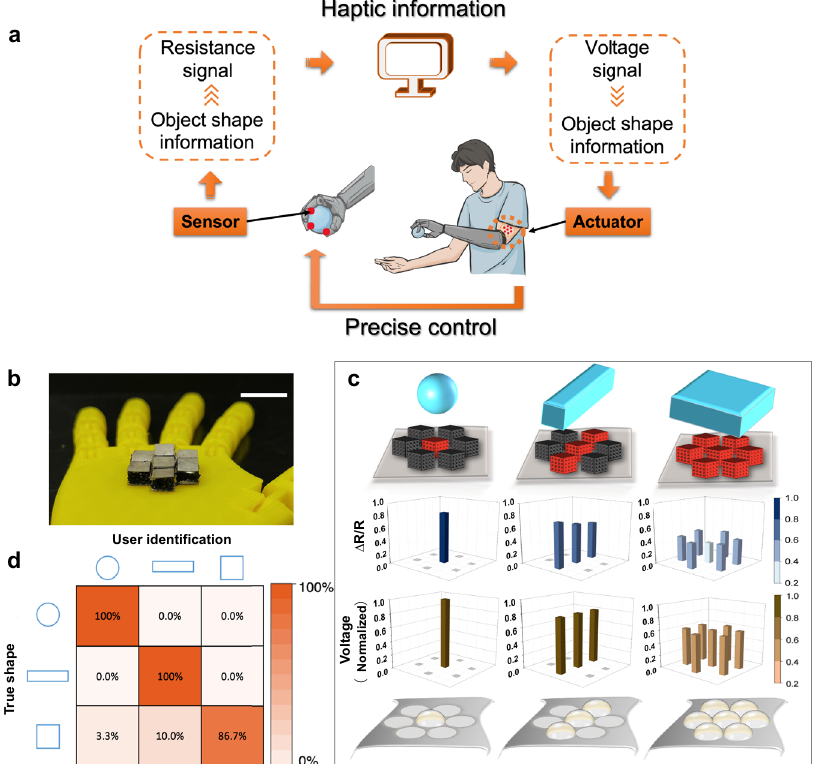
Fig. 8 Object shape recognition. a Schematic diagram of the closed-loop haptic feedback system for object shape recognition. b Picture of the pressure sensor array attached to the robot hand (Scale bar: 10 mm). c From top to bottom: the sensor array activated by a sphere, bar, and cube; resistance changes detected by the pressure sensor array corresponding to different shapes; corresponding voltage signals applied to the actuators; actuators activated in response to the applied voltage. d Confusion matrix showing the result of the shape recognition user